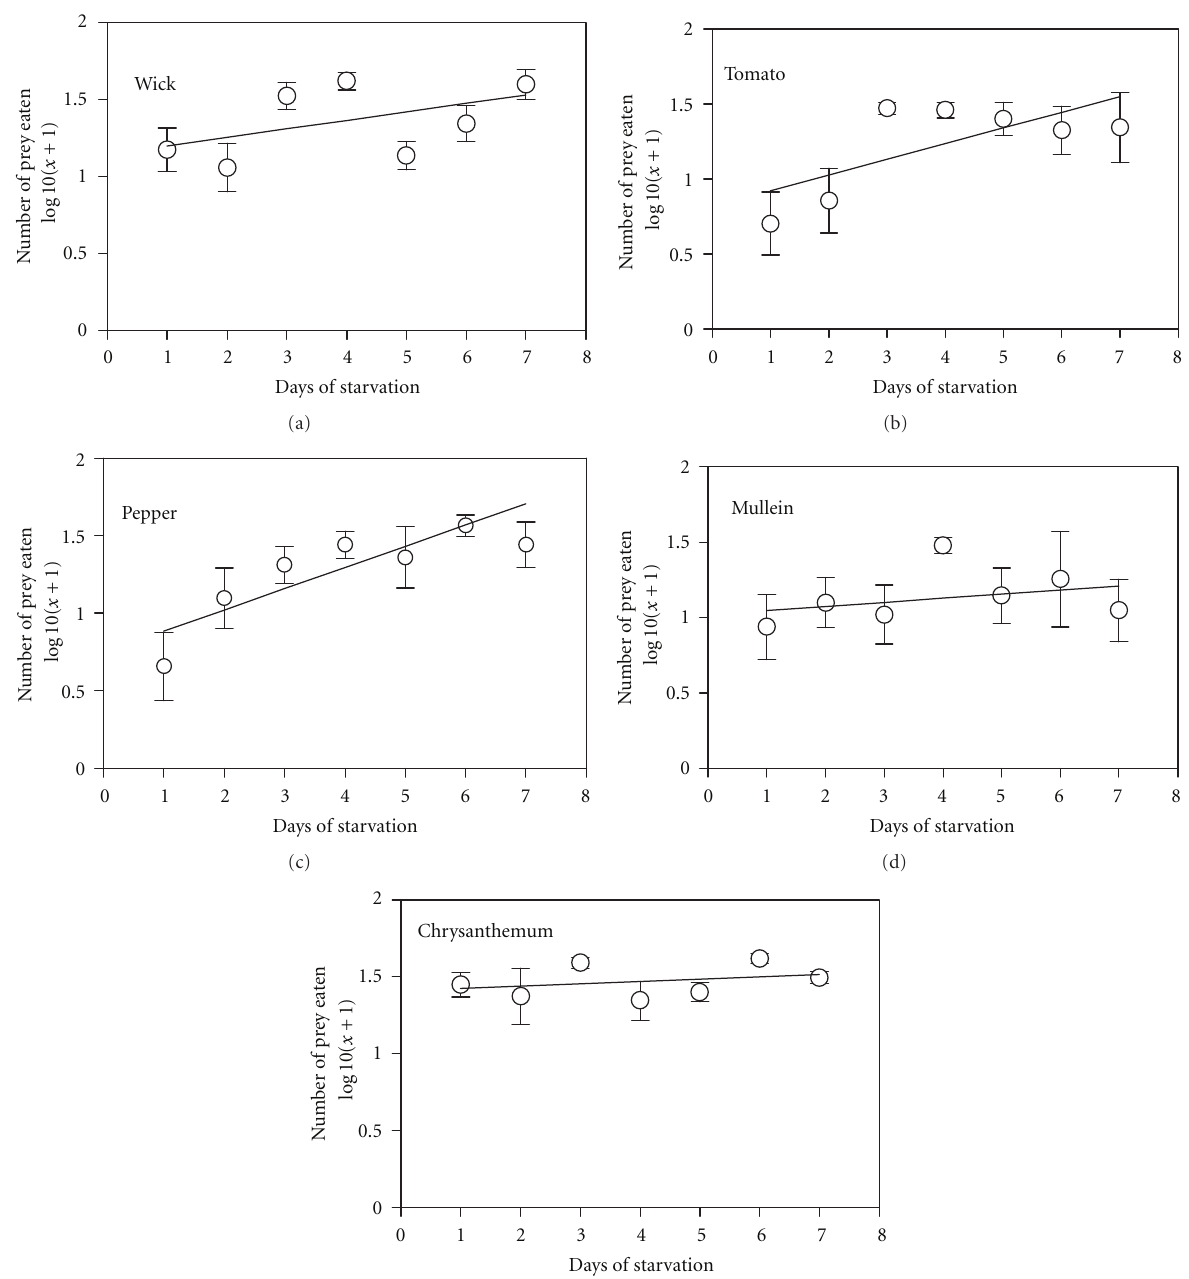
Figure 2: Number of prey consumed by female D. hesperus after di ff erent periods of starvation while confined to chrysanthemum, mullein, pepper, or tomato leaves, or with a wick providing water. N varies from 10 to 3 for each